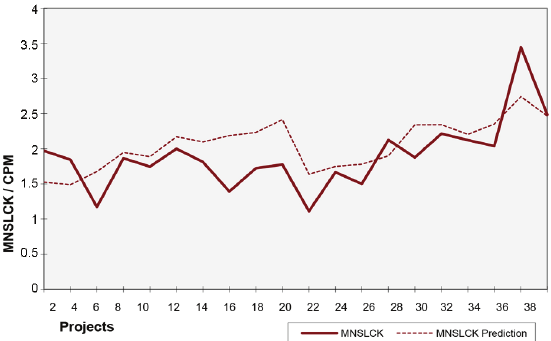
Fig. 5. The estimated values for project time as per the MNSLCK priority rule in testing